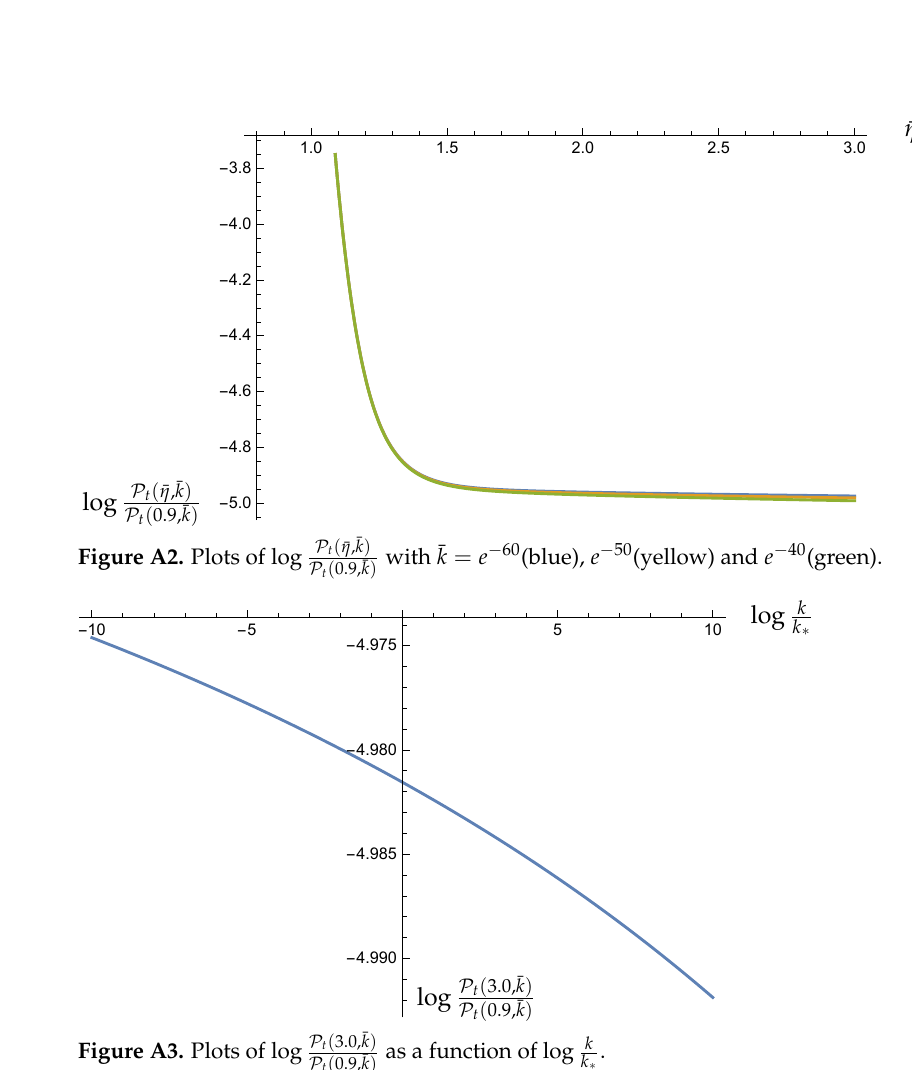
Figure A3. Plots of log P t (